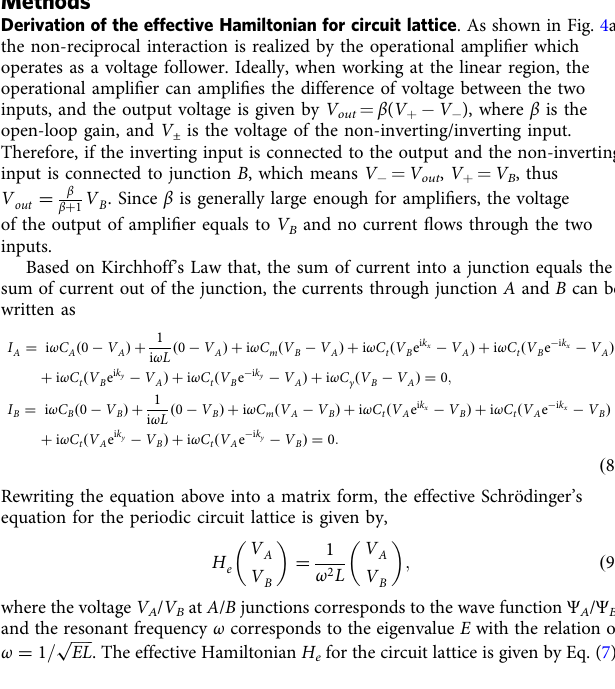
Fig. 5 Simulation results of the topolectrical circuit. a – d Show the results for phase I with electronic components L = 5.6 μ H, C A = 100 pF, C B = 150 pF, = 160 pF, C = C = 50 pF, and ( e – h ) show the results for phase IV with components L = 5.6 μ H, C C m t γ Frequency response of the topolectrical circuit lattice under periodical boundary condition, where the ideal model results and simulation results are colored by light red and gray respectively. b , f Exceptional rings stimulated by the on-site frequency f 0 ¼ 1 = ð 2 π topolectrical circuit under open boundary condition. d , h The amplitude of the localized topological boundary modes stimulated by the on-site